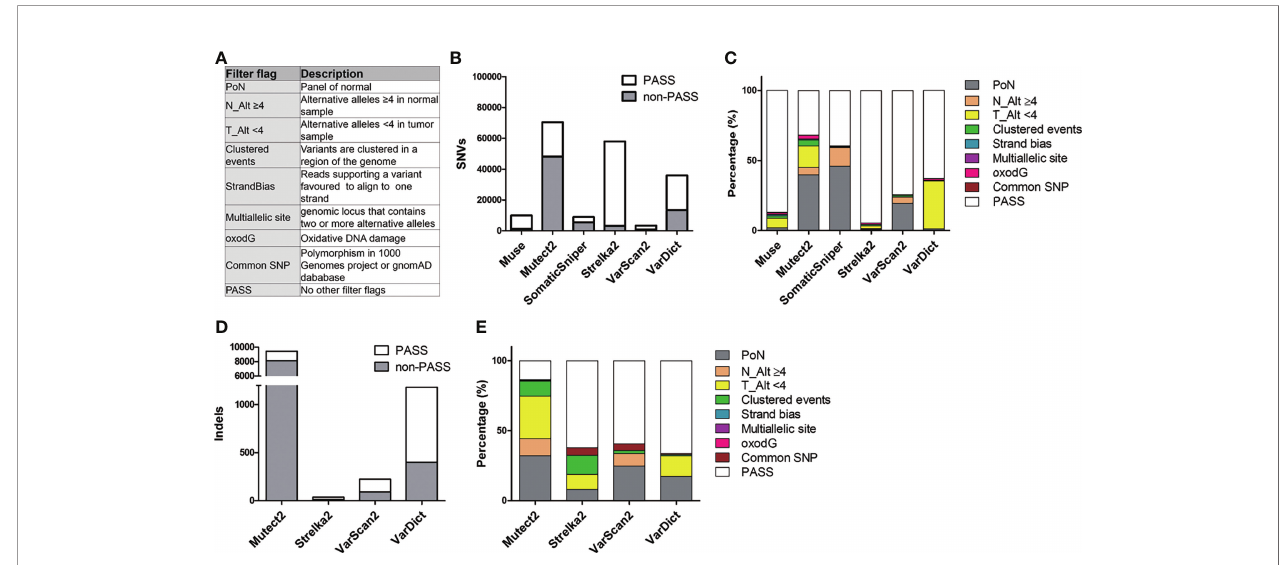
FIGURE 2 | Description of fi lter fl ag distribution in six callers. (A) Purpose of the fi lter fl ags. (B) The count of PASS and non-PASS SNVs for each caller. (C) The stacked bar chart illustrates the proportion of different fi lter fl ags in SNVs for each caller. (D) Representation of the amount of PASS and non-PASS indels. (E) Histogram of the proportion of different fi lter fl ags in indels.